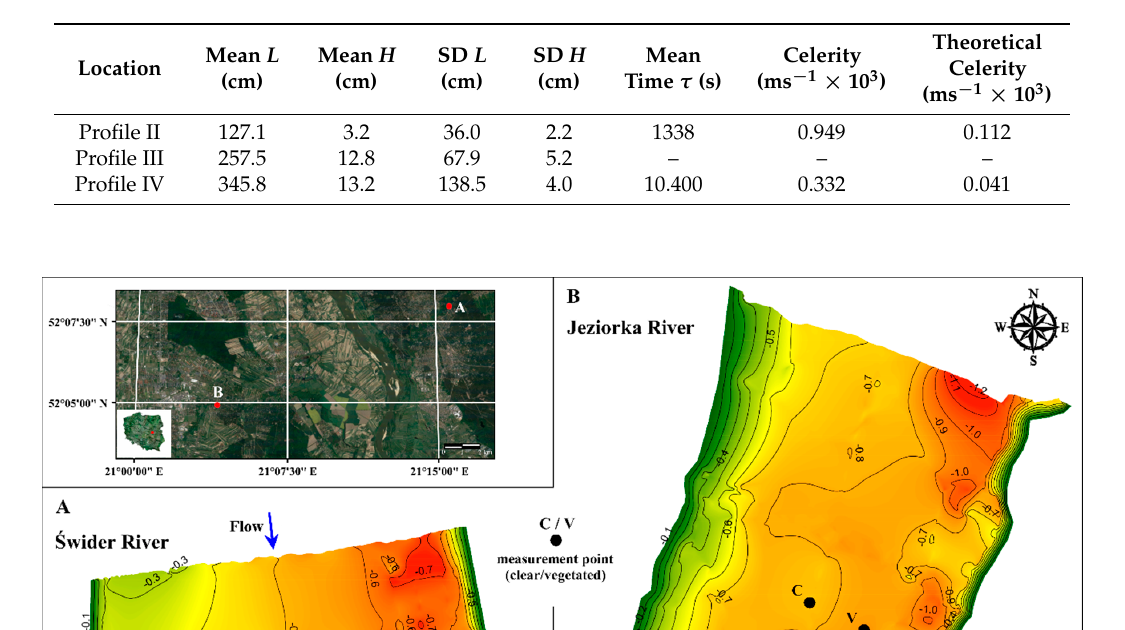
Table 2. Statistics of sand waves in the considered profiles in the Ś wider River. L denotes length of a dune; H denotes height of the dune; SD denotes standard deviation.